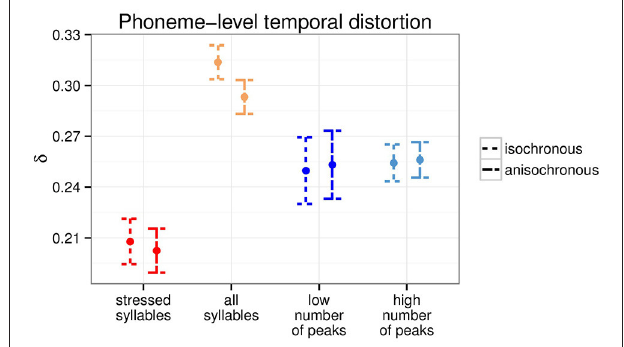
FIGURE 3 | Phoneme-level temporal distortion for the two anchor point types at the two time scales ( N =